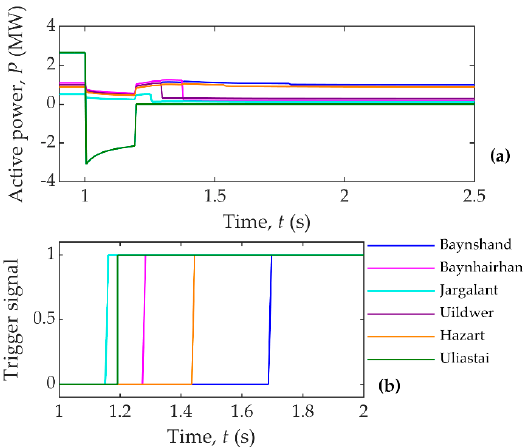
Figure 11. UFR action in low inertia—winter season scenario: ( a ) active power; ( b ) trigger signal of the UFRs.